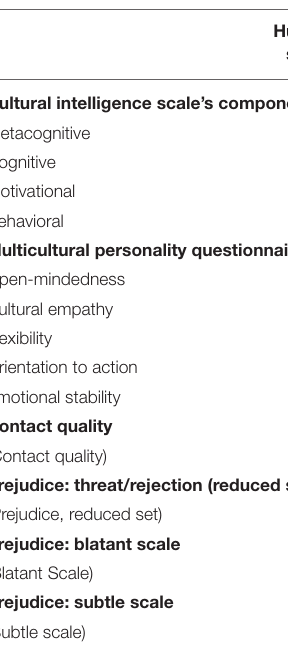
TABLE 3 | Internal consistencies for all scales and